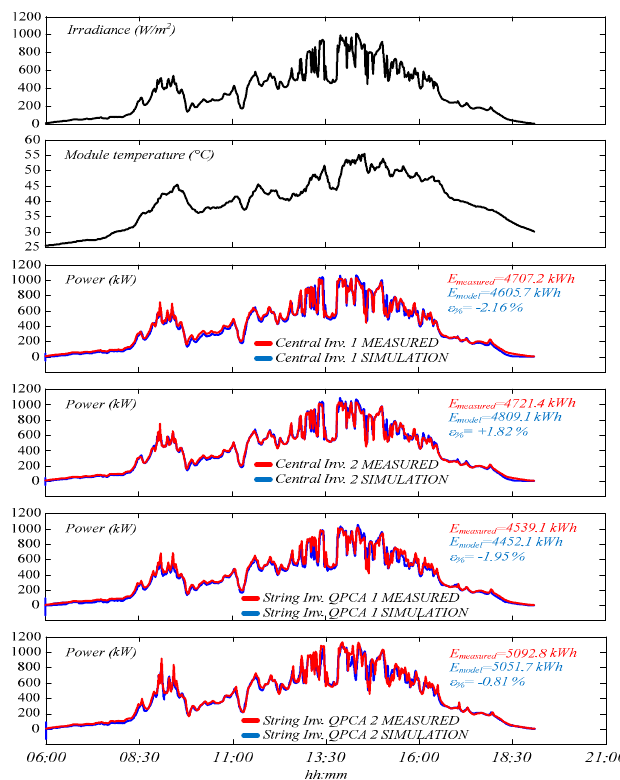
Figure 12. Another example of daily power curves measured for each experimental subfield of the PV plant in Brazil. Model output (simulation) vs measured data. Calculation of percentage relative error.